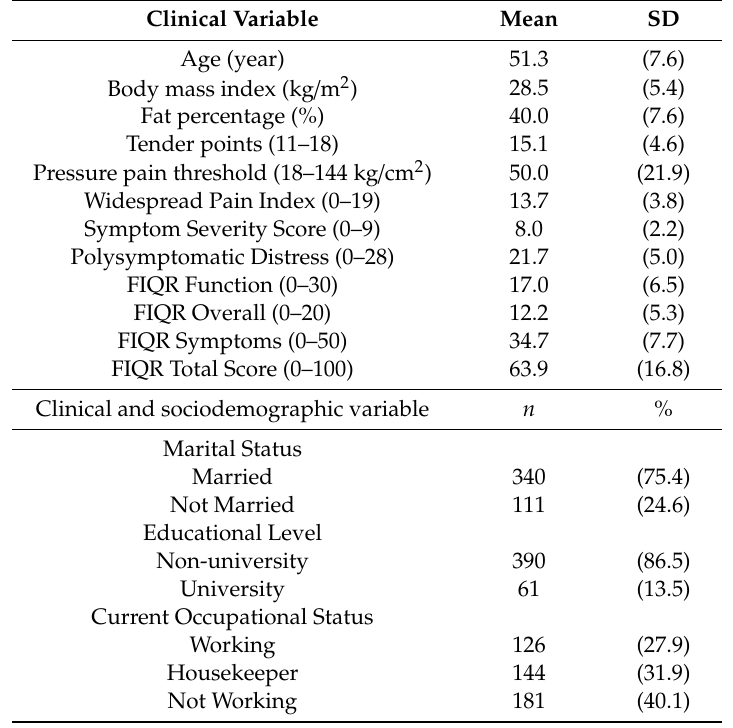
Table 1. Clinical and socio-demographic characteristics of fibromyalgia women, n =